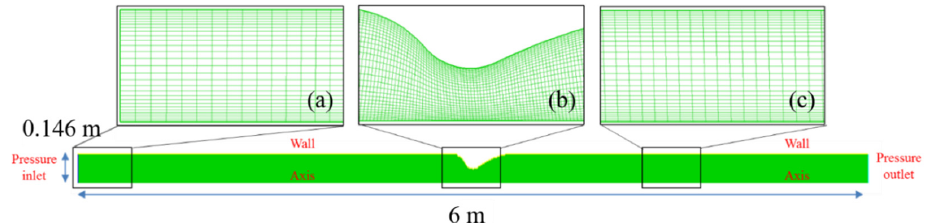
Figure 2. Grids in physical domain for pipe flow for steady and unsteady computational fluid (CFD) simulations ( a ) pipe inlet; ( b ) pipe throat; ( c ) pipe outlet.